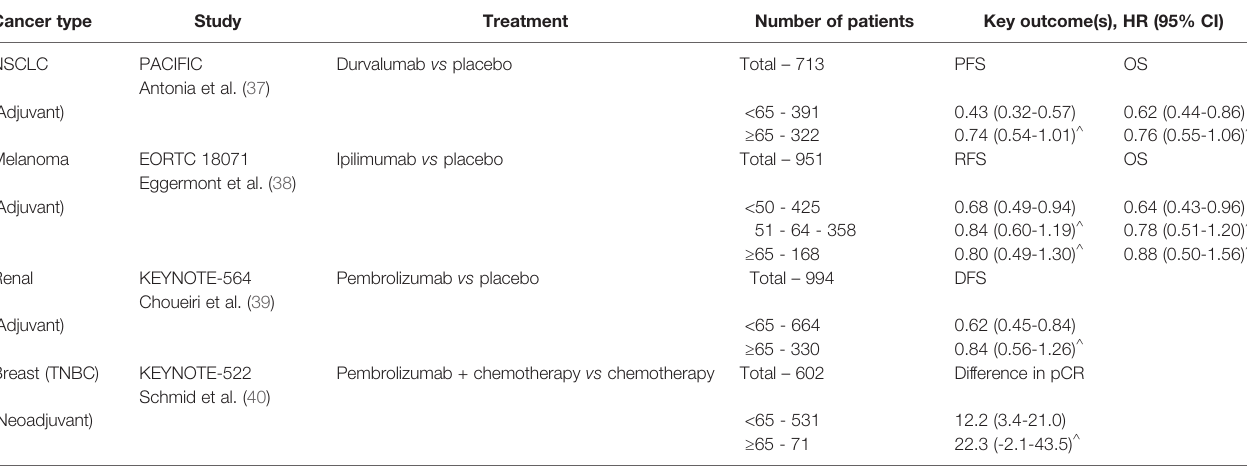
TABLE 3 | Select phase III trials of ICIs as adjuvant or neoadjuvant